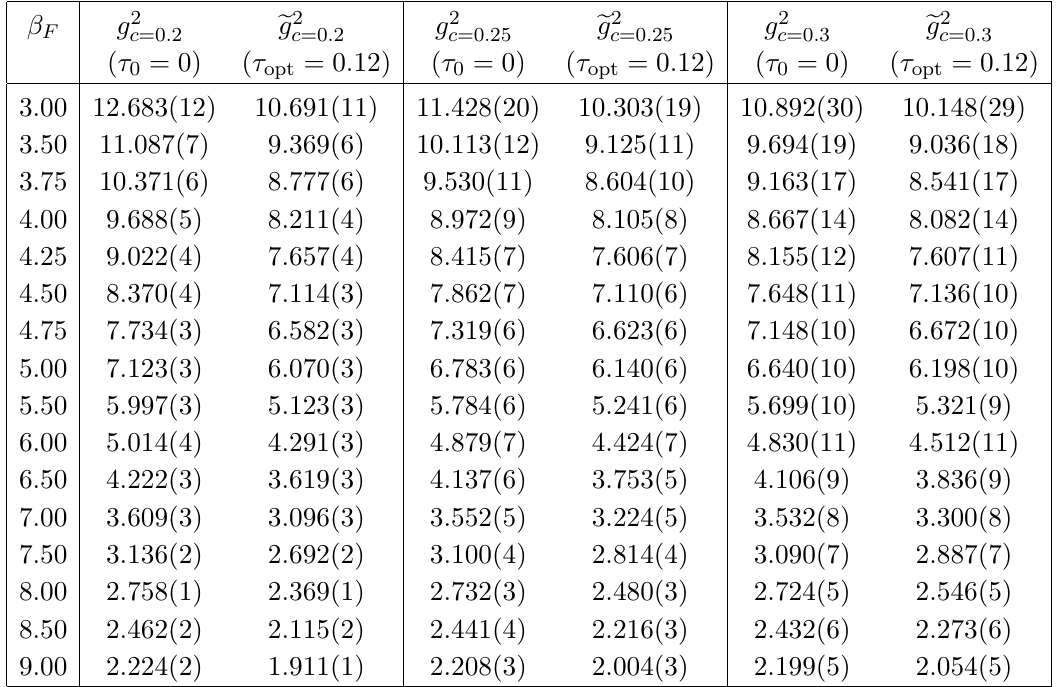
Table 17 . Renormalized gradient (cid:13)ow couplings based on the plaquette discretization of E ( t ) for the 18 4 lattice ensembles used in this work, with columns as in table 15.